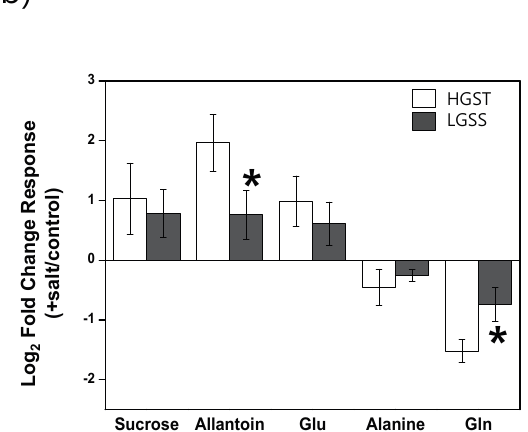
Figure 4. ( a ) Box and whisker plots for the changes of the salt-responsive metabolites in 38 rice genotypes. Maximum and minimum values of a metabolite among each group represented at the upper and lower end of the whisker, respectively, and their 75th and 25th percentiles are represent at the upper and lower end of the box, respectively; ( b ) Comparison of salt-induced fold changes of metabolites between high growth and salt-tolerant (HGST) and low growth and salt-sensitive (LGSS) rice cultivars. Columns indicate the log 2 of the peak area ratio for metabolites in the control versus salt-treated rice roots. The log 2 of the peak area means the log 2 ratio of the average peak intensity in the salt-treated rice roots to that in the control roots. A single asterisk indicates a statistically-significant difference ( p < 0.05). Bars indicate the standard